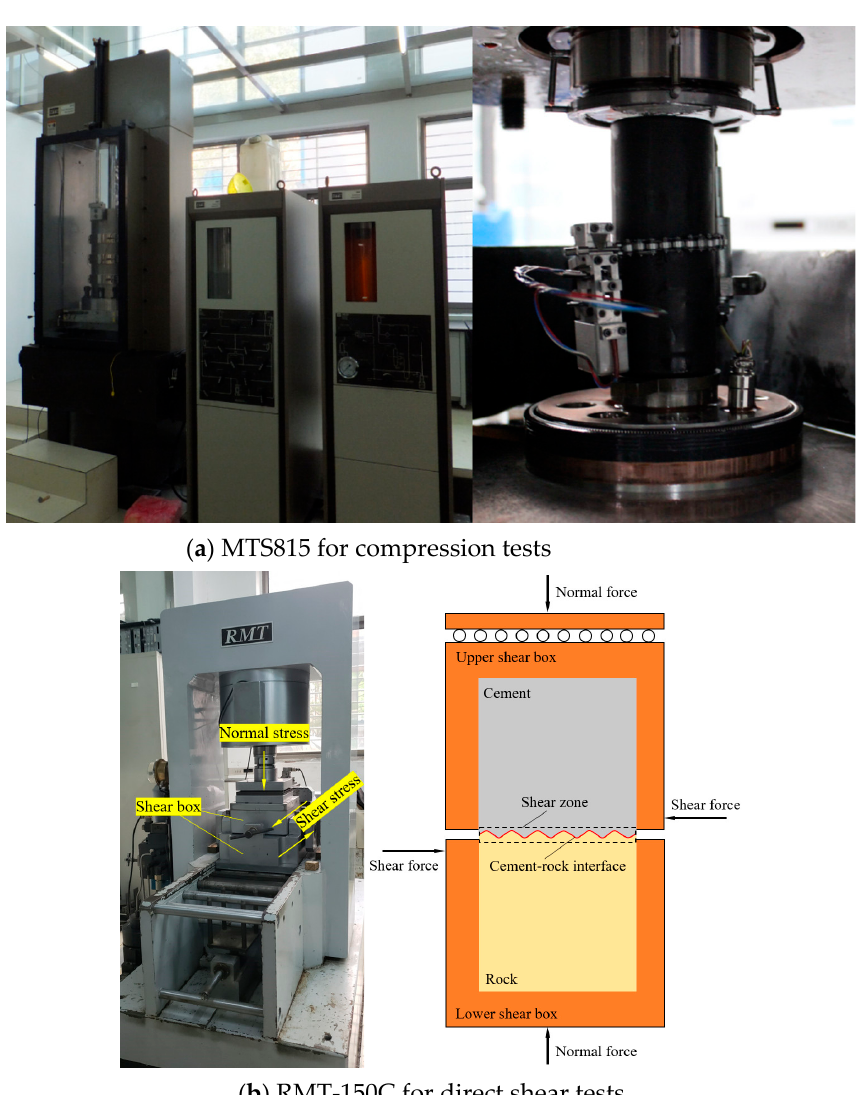
Figure 4. Test system for compression and direct shear experiments.